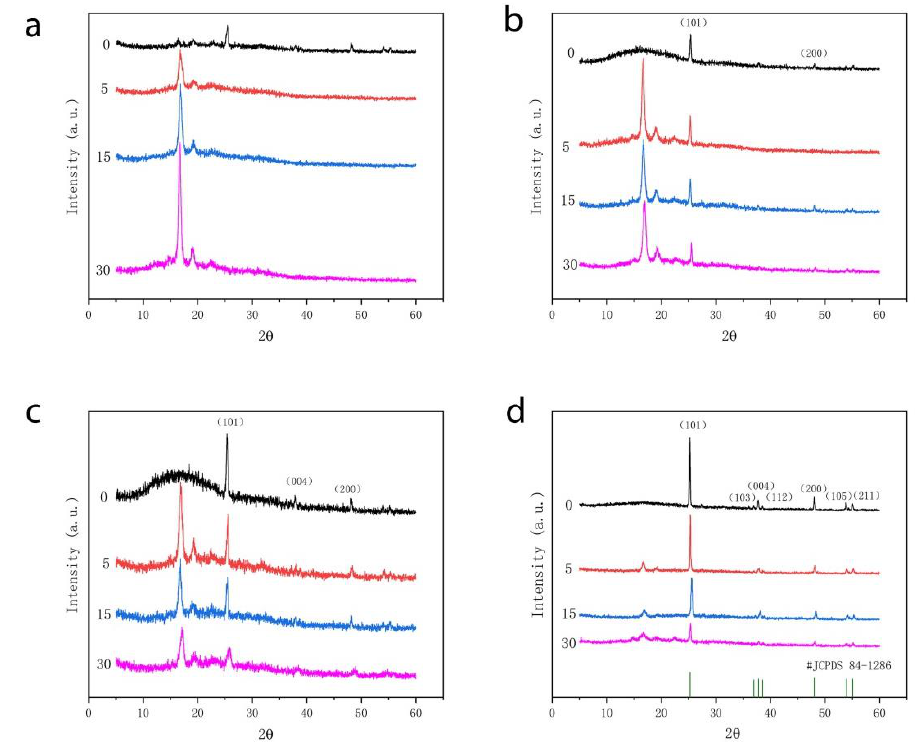
Figure 3. X-ray diffraction (XRD) curves of ( a ) PLA, ( b ) PLA/Ti5, ( c ) PLA/Ti10, and ( d ) PLA/Ti20 composite films treated by high pressure contacting with ethanol solution on day 0, 5, 15, and 30.